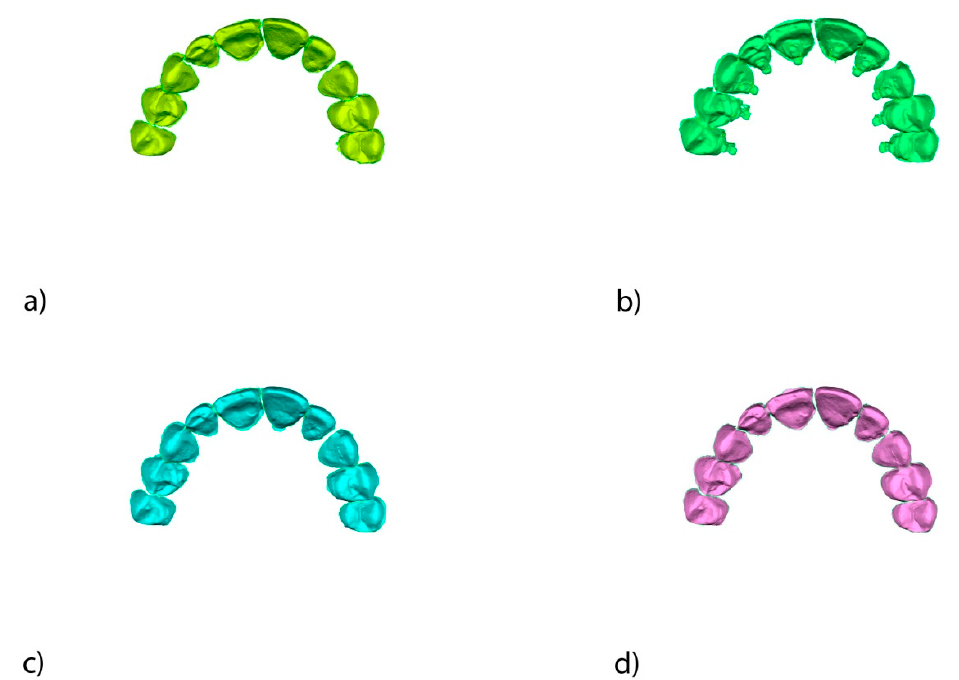
Figure 2. Occlusal view of the individually segmented teeth from 1.5 to 2.5 of the standard tessellation language (STL)1 ( a ), STL2 ( b ), STL3 ( c ), and STL4 ( d ).